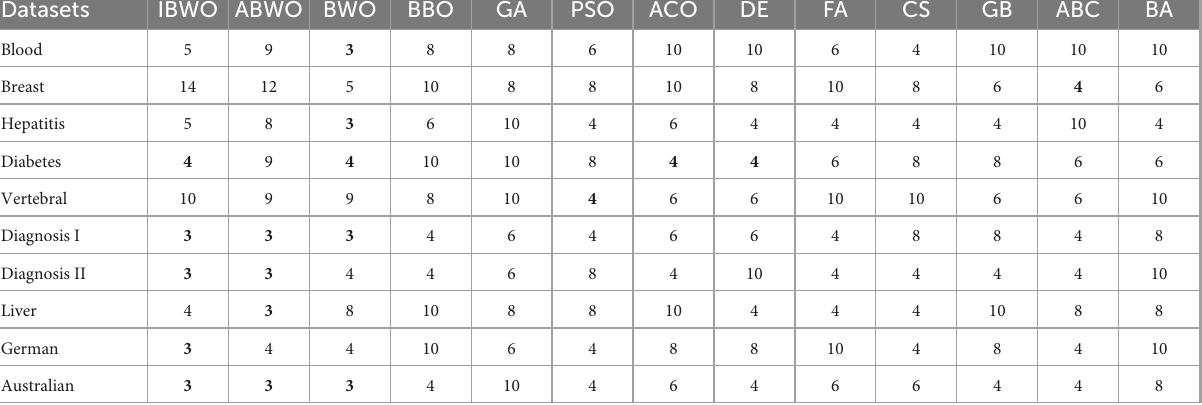
TABLE 3 Minimum number of hidden neurons for 13 algorithms on 10